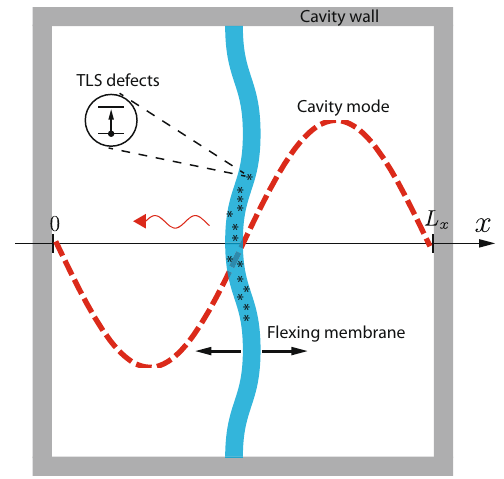
Fig. 1 Cavity-accelerating photodetectors scheme. A two-dimensional membrane (shown in crossection) located at x = L x /2, midway between cavity wall (mirror) boundaries at x = 0, L x , undergoes fl exural vibrations normal to its surface in the x -coordinate direction, resulting in the oscillatory acceleration of pointlike, two level system (TLS) photodetectors embedded within the membrane. An accelerating TLS can undergo a transition to its excited state level, with the accompanying emission of a photon into the cavity mode vacuum. A possible implementation might utilize a diamond membrane with nitrogen vacancy (NV) defect centres 20,23,24 furnishing the TLSs, where the fl exural vibrations of the membrane are induced for example by piezoactuators (not